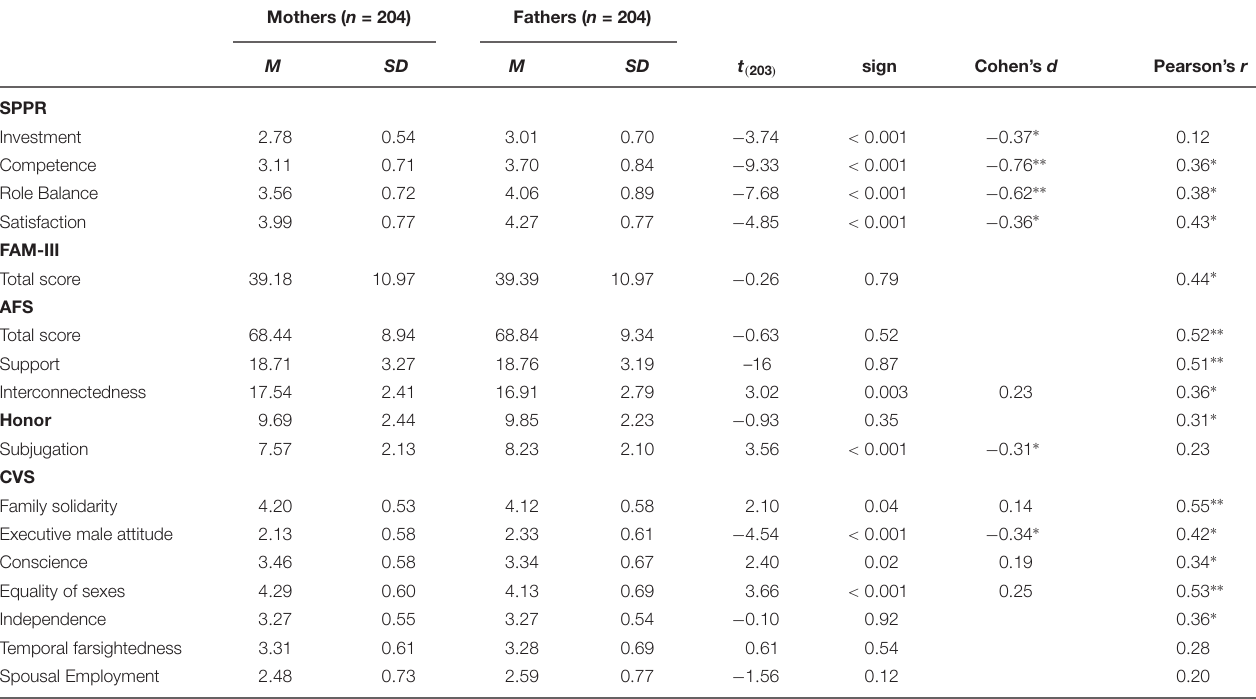
TABLE 1 | Means, Standard Deviations, and Paired t -test for mothers and fathers for all the selected